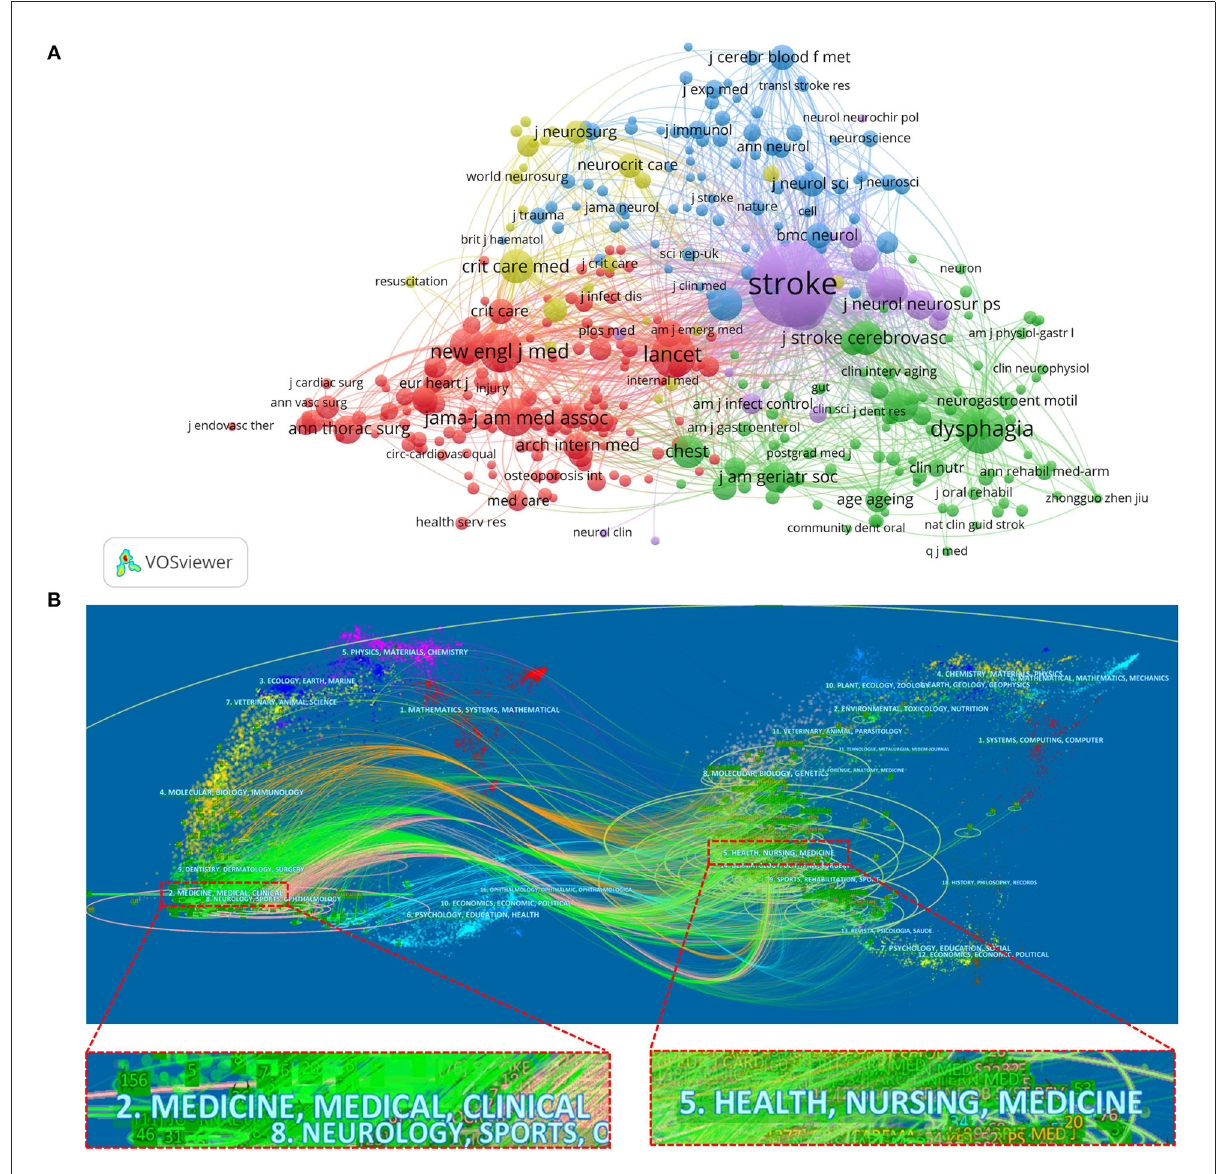
FIGURE7 (A) The network visualization map of journals for co-citation analysis performed by VOS viewer. (B) The dual-map overlay of the journals involved in post-stroke pneumonia research generated by CiteSpace.